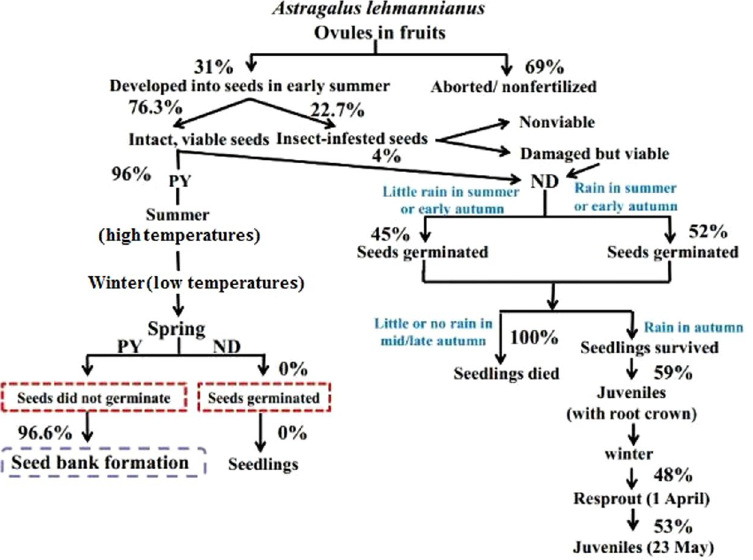
Figure 6. Conceptual model of the effects of “out-of-season” germination due to seed predation on the early life history stages of Astragalus lehmannianus in the field. ND, seeds nondormant; PY, physical